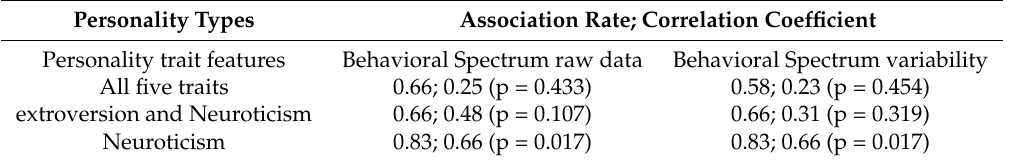
Table 6. Association between personality traits and user activity trials in HS data during the night